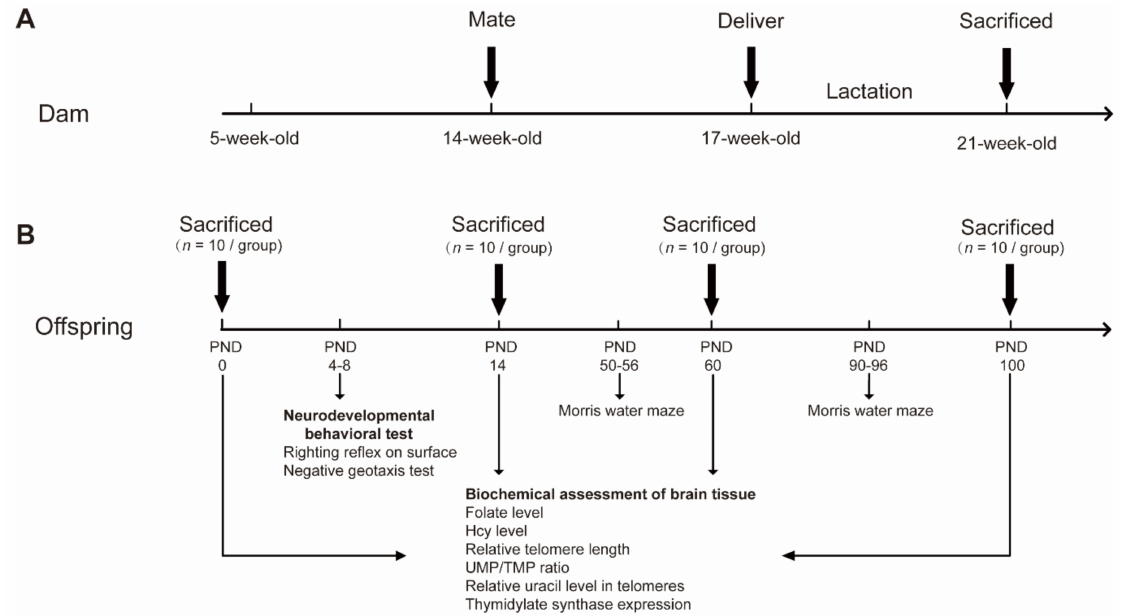
Figure 7. Flow chart of maternal and offspring experimental design. Three groups of the female rats were fed folate-normal, folate-deficient, or folate-supplemented diets before and during pregnancy, and the offspring were fed the corresponding diet after weaning. ( A ) Experimental design of dams. Dietary treatment began at 5 weeks of age. After two months of dietary treatment, the dams were mated with male rats with a 2:1 female-to-male ratio. After the delivery of their pups, all dams were fed the corresponding diet. After the lactation period, the dams were sacrificed. The duration of folic acid intervention was not limited to the pregnancy period but ran throughout the two months before pregnancy, the entire pregnancy period, and after weaning to postnatal 100 days. ( B ) Experimental design of offspring. The offspring were sacrificed and collected materials on PND0, PND14, PND60, and PND100. We performed the neurodevelopmental behavioral test on offspring rats on PND4, PND 5, PND 6, PND 7, and PND 8. At PND50 and PND90, we conducted a Morris water maze test on offspring